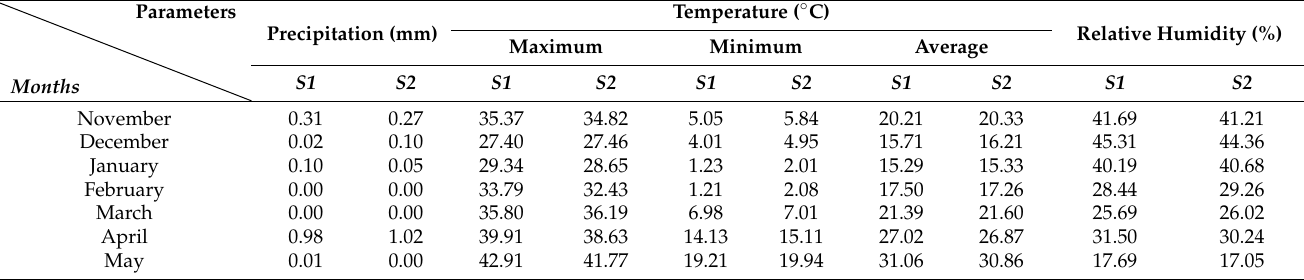
Table 1. Monthly agro-climatological data at the experimental location during the growing